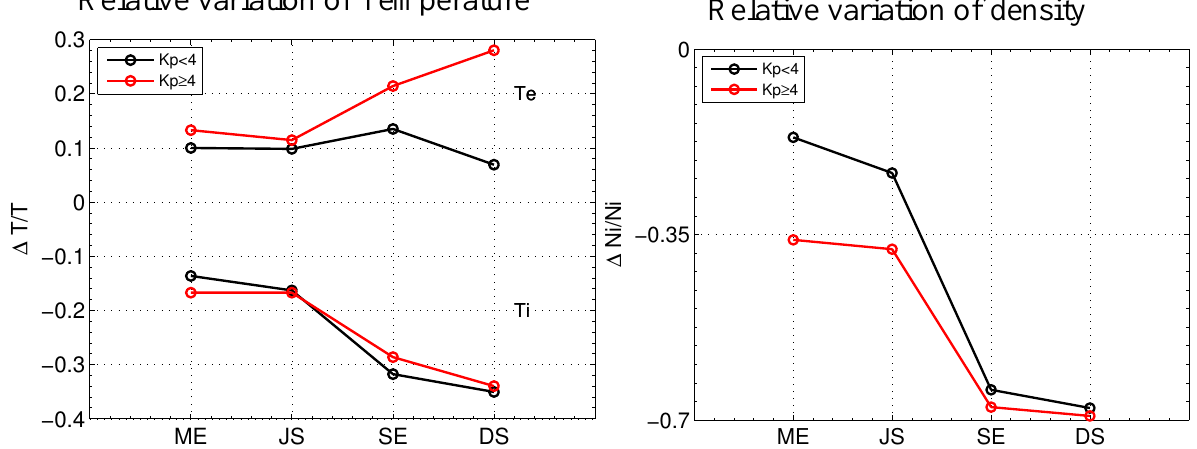
Fig. 11. Relative variation of both ion and electron temperature (left) and ion density (right) at the key MLat at 800 km altitude for Kp < 4 and Kp ≥ 4 for each season. The ∆ means the subtraction of the background value.